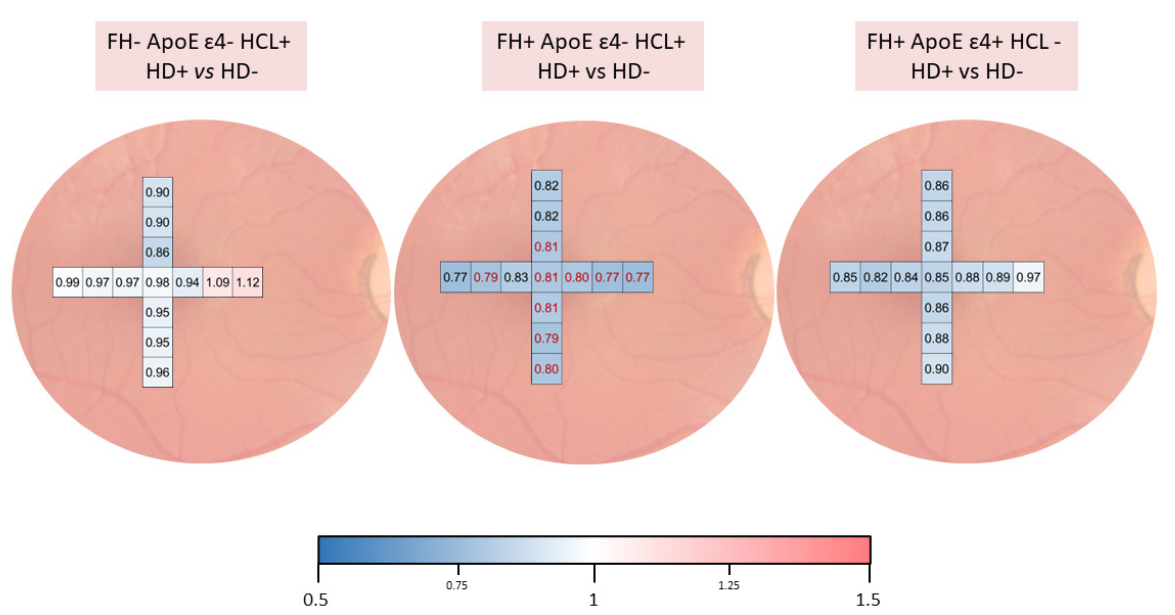
Figure 3. Colorimetric representation of choroidal thickness analysis at different points between participants with and without drusen in FH-ApoE ε 4- HCL+, FH+ ApoE ε 4- HCL+, and FH+ ApoE ε 4+ HCL-. Thinning is shown in shades of blue, while thickening is shown in red tones.